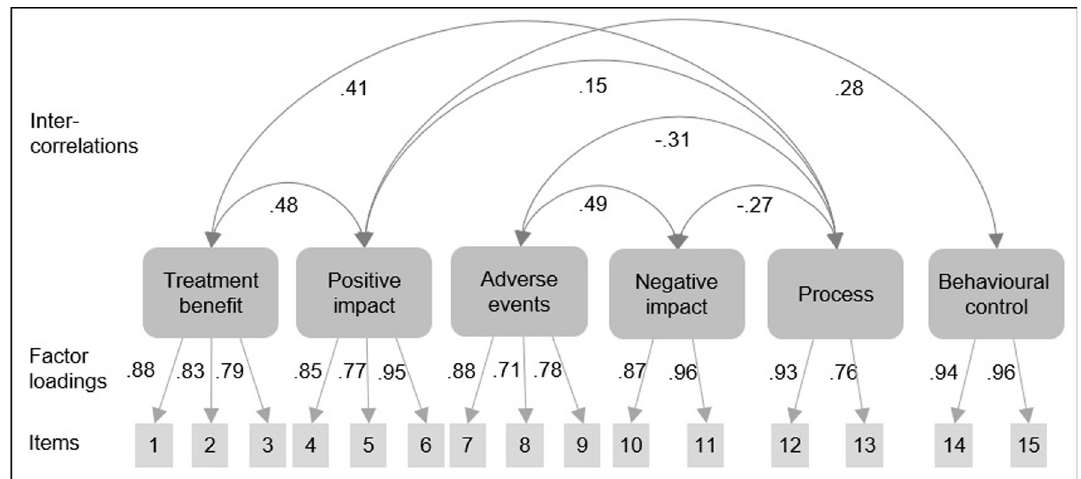
Fig 2. Factorial structure with factor loadings (n = 251) of the Treatment Expectation Questionnaire (TEX-Q).